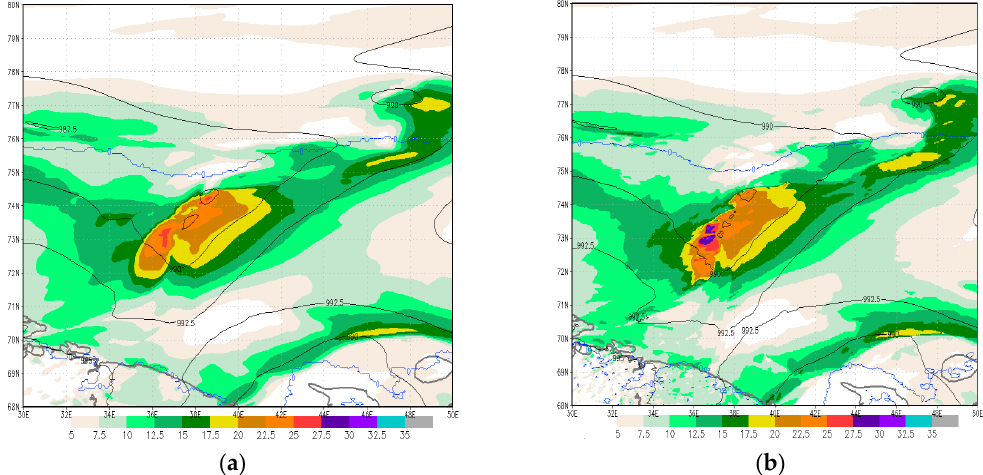
Figure 11. ICON ‐ A6.5 ( a ) and ICON ‐ A2 ( b ). Vertical profiles of the 10 m wind speed along 38.5° E. Valid time 04:00 UTC